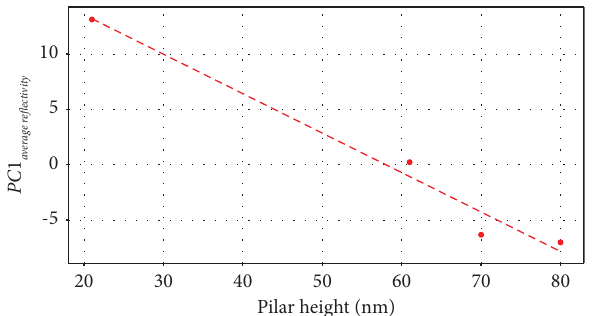
Figure 7: Dependence of PC1 average refectivity on pillar height: both quantities are inversely proportional in frst approximation.